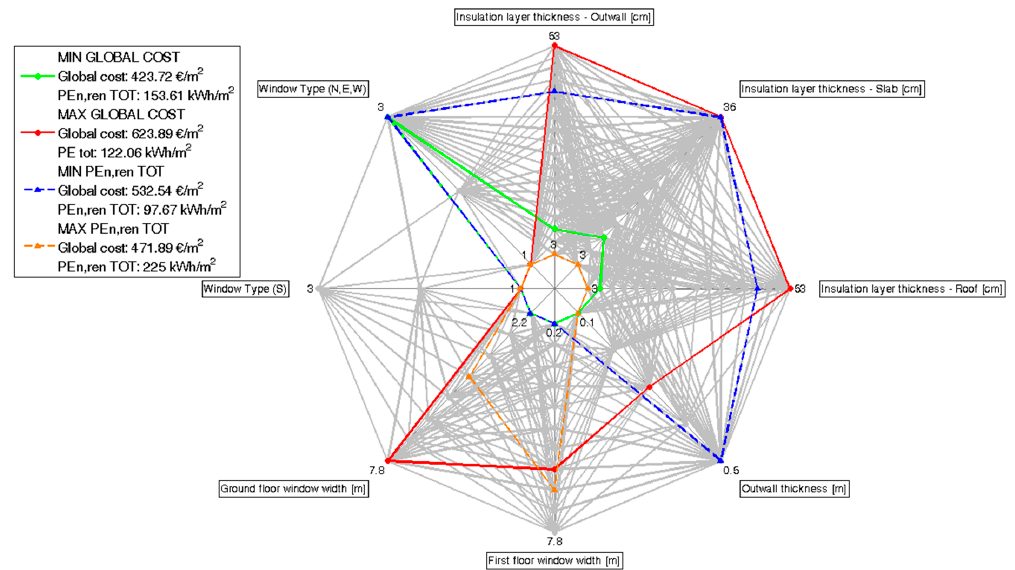
Figure 5. Design configuration networks: financial objective, sequential optimization, energy demand.